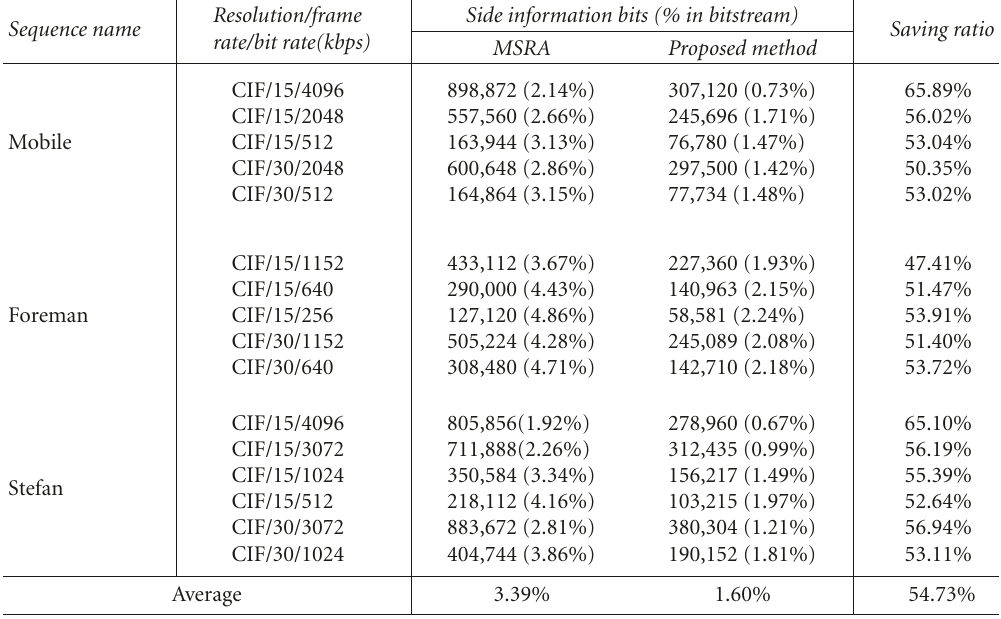
Table 2: Side information saving ratio.